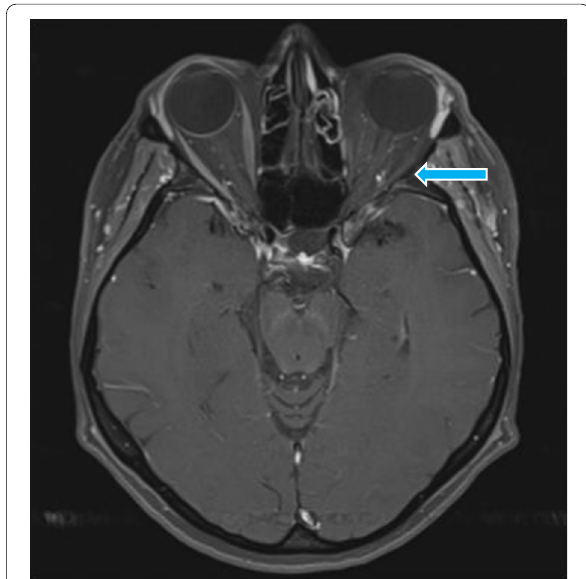
Fig. 2 Post‑contrast, axial T1‑weighted fat‑saturated image at presentation. The orbital structures, including the ocular bulb and the rectus muscles on the left side, show no contrast enhancement indicating an ischemic